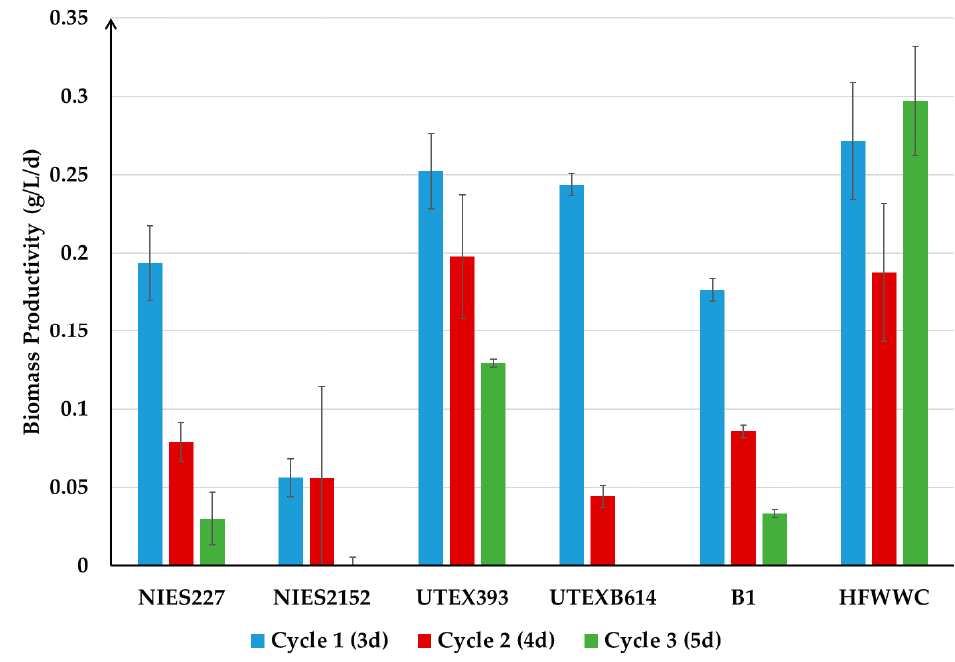
Figure 3. Biomass productivity for four strains (NIES 227, NIES 2152, UTEX 393, and UTEX B614) and two consortia (B1 and HFWWC) grown in HFWW in a semi-continuous mode of 3 (cycle 1), 4 (cycle 2) and 5 (cycle 3) days.